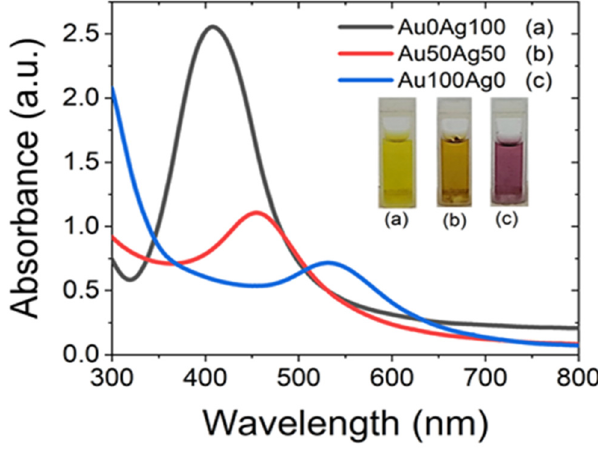
Figure 2. The result of UV-Vis absorption spectra of Au0Ag100, Au50Ag50 and Au100Ag0 nanoparticles following irradiation of a femtosecond laser for 5 min. Inset: the photograph of their colloidal nanoparticles in room light.